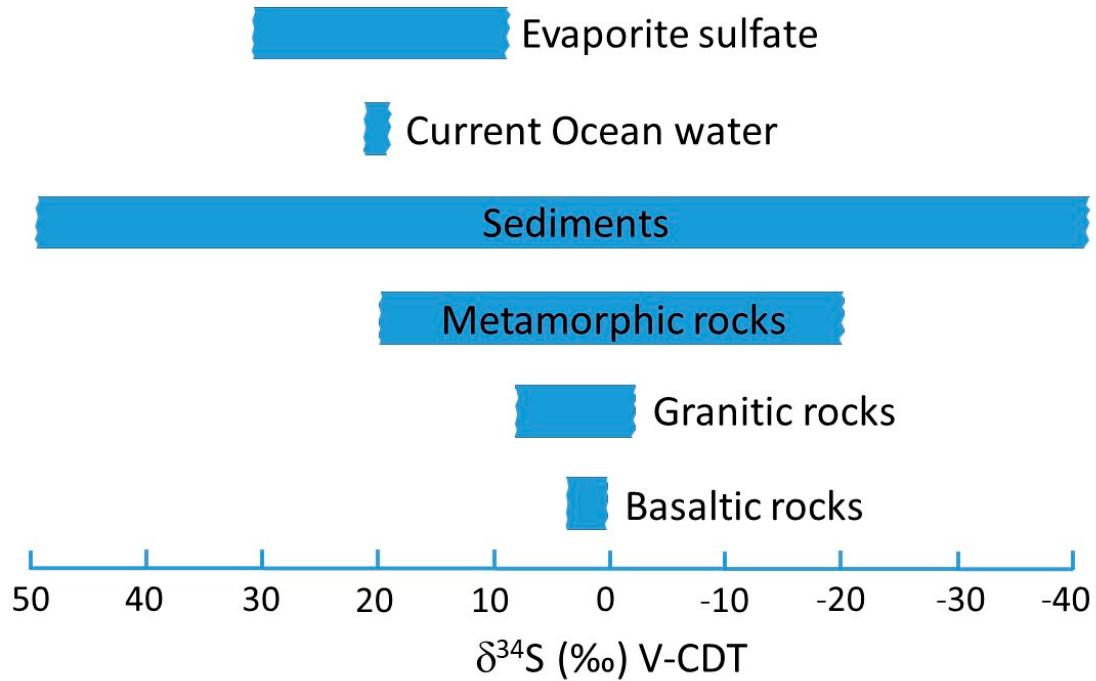
Figure 2. Sulfur isotope ranges in rocks, after Hoefs [8] and Horacek et al., 2010 [10], modified. Volcanic rocks belong to the groups “Basaltic rocks” and “Metamorphic rocks”, the latter group also representing acidic volcanic rocks from recycled continental crust. VCDT: Vienna Canyon Diablo Troilite.